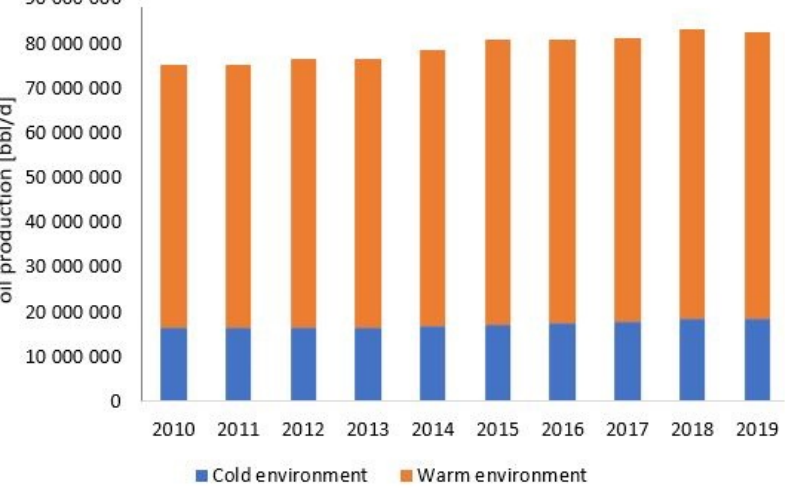
Figure 2. Yearly oil production as a function environmental temperature.